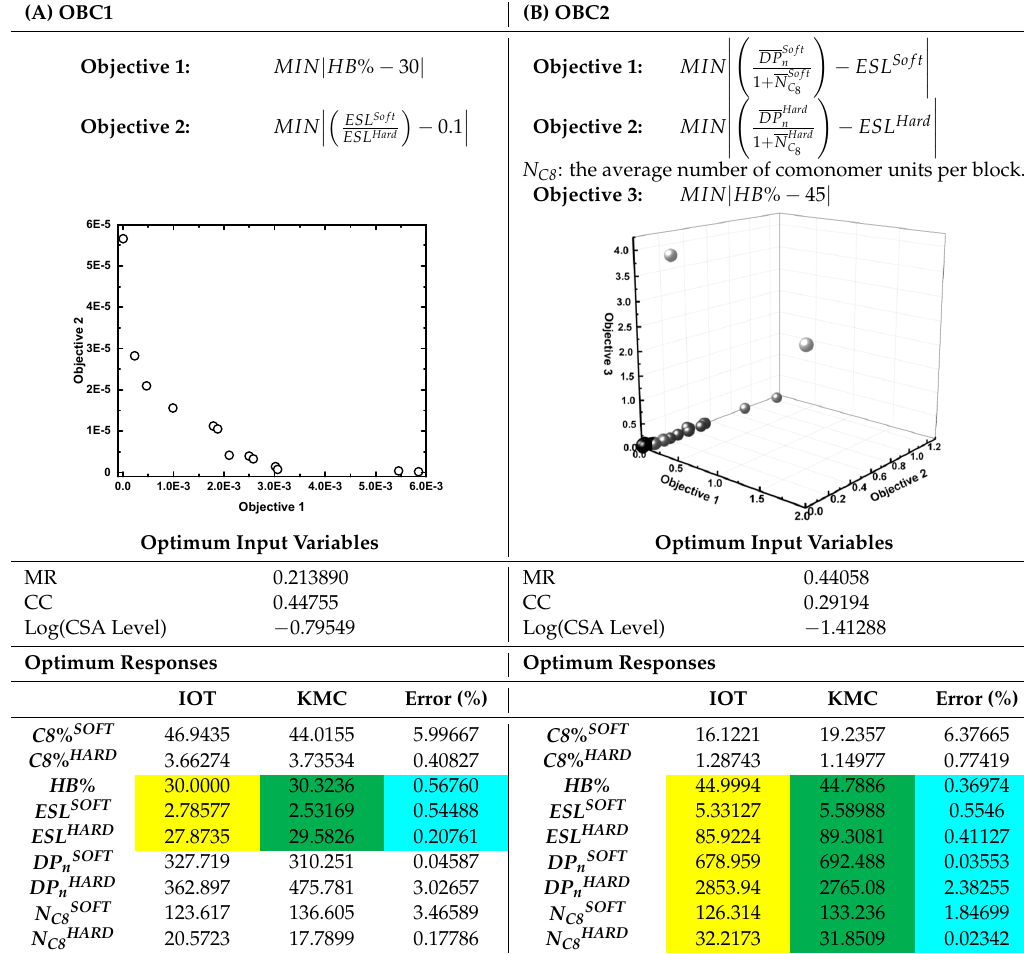
N C8 : the average number of comonomer units per block.